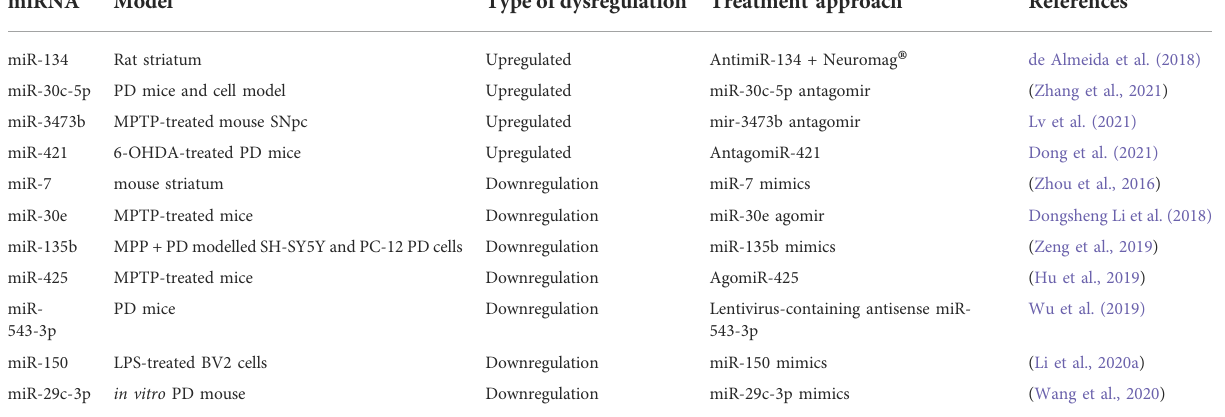
TABLE 3 Pre-clinical and in vitro data of miRNA-based therapeutics for